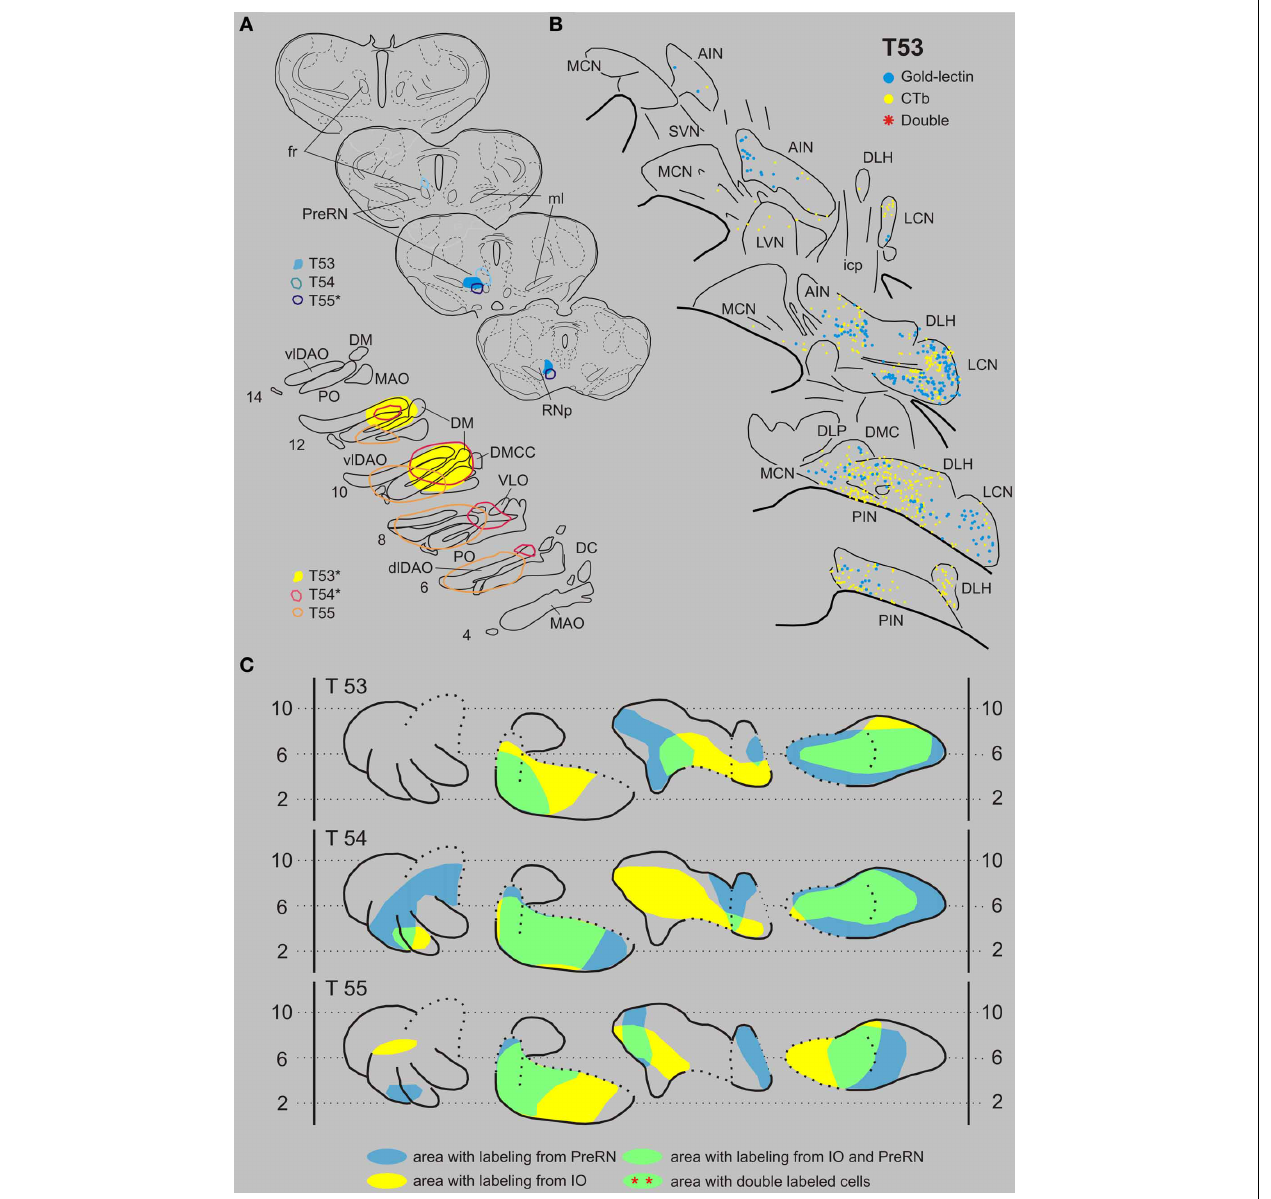
T53. (C) Overview of the distribution of retrogradely labeled neurons of case T53 and of the two additional cases (T54 and T55) in standardized diagrams of the CN. Areas containing labeled neurons from the PreRN and IO are indicated in blue and yellow, respectively. In all cases virtually no double-labeled neurons were encountered ( Table 1 ). Abbreviations: PreRN, prerubral area; fr, fasciculus retroflexus; SN, substantia nigra. Conventions and other abbreviations as in Figure 3